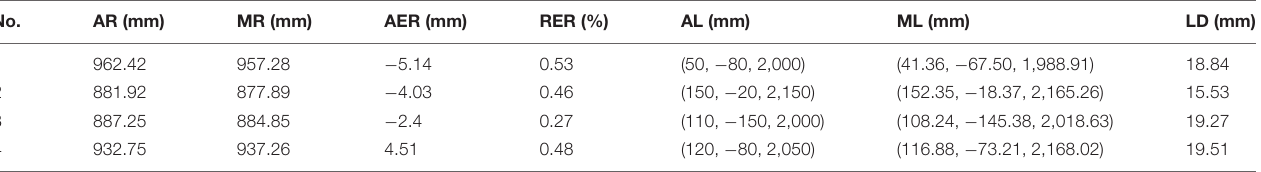
TABLE 3 | Outdoor test results of center coordinate and its